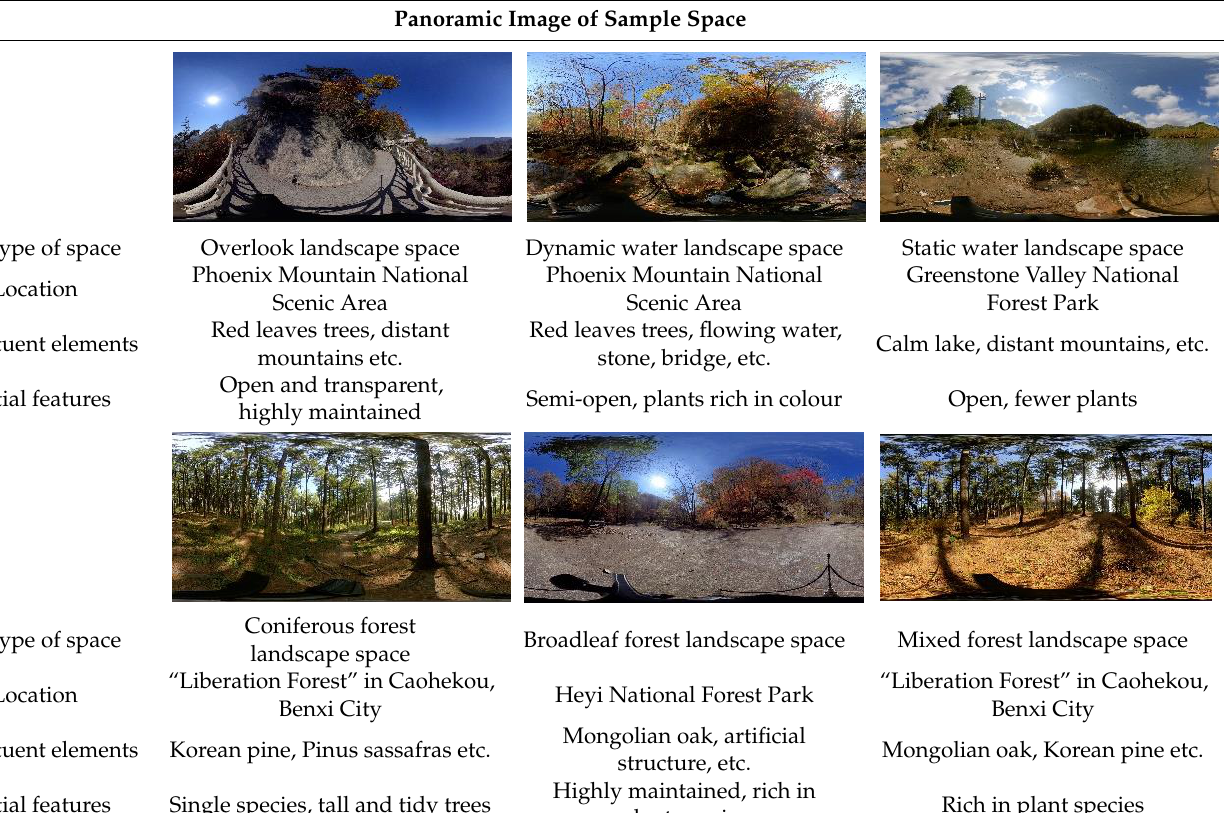
Table 1. The basic characteristics of the sample spaces.